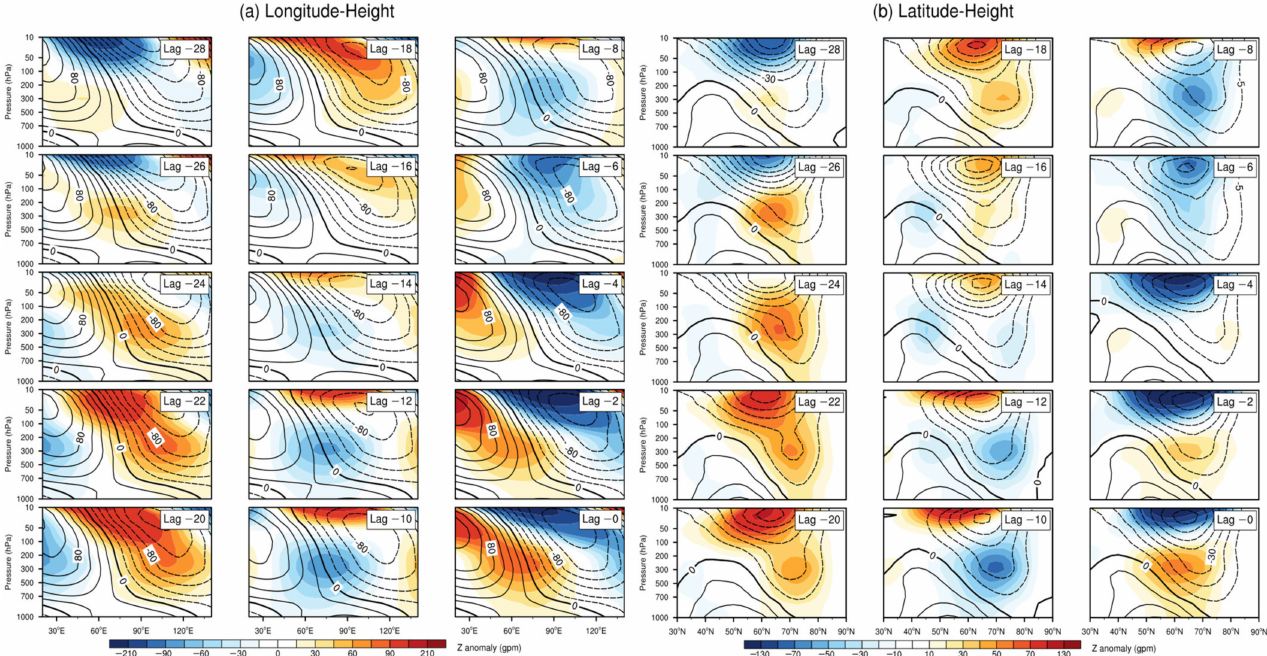
Figure 11. ( a ) Longitude–height cross sections of 10–60-day filtered wave 2 geopotential height anomalies (shadings; unit: gpm) and wave 2 climatological geopotential height (contours; unit: gpm) along 35 ◦ –80 ◦ N from Lag − 28 to Lag 0. Contour interval is 20 gpm. ( b ) Latitude-height cross sections of 10–60-day filtered wave 2 geopotential height anomalies (shadings; unit: gpm) and wave 2 climatological geopotential height (contours; unit: gpm) along 20 ◦ –140 ◦ E from Lag − 28 to Lag 0. Contour interval is 10 gpm.